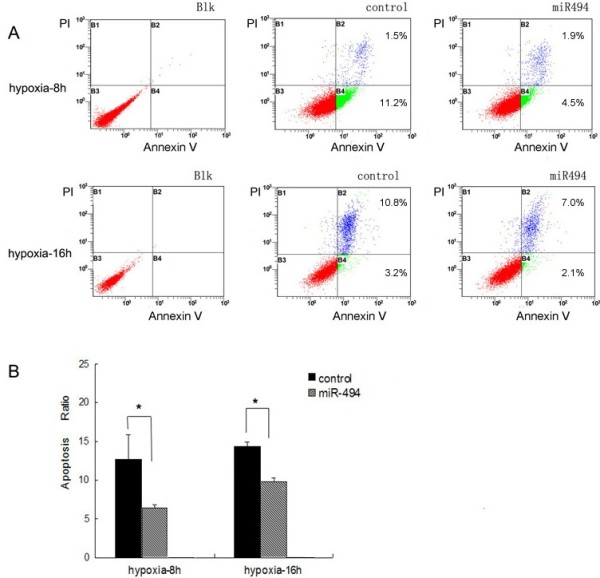
Effect of miR-494 on hypoxia-induced apoptosis was determined with Annexin V-FITC/PI binding staining by flow cytometry. (A) Flow cytometry results with Annexin V-TITC/PI staining. Cells were transfected with miR-494 mimic or miR-negative control as described above. After hypoxia for 8 hours (Top) or 16 hours (Bottom), cells were harvested and then apoptosis was analyzed with an Annexin V-FITC Apoptosis Detection Kit by flow cytometry. Cells were classified as healthy cells (Annexin V−, PI−), early apoptotic cells (Annexin V+, PI−), late apoptotic cells (Annexin V+, PI+), and damaged cells (Annexin V−, PI+). (B) The ratio of apoptosis among different experimental groups. Apoptosis ratio was early apoptosis percentage plus late apoptosis percentage. Control indicated miR-negative control. The data were presented as the means ± SD. Columns, mean of three independent experiments; bars, SD; *p < 0.05.